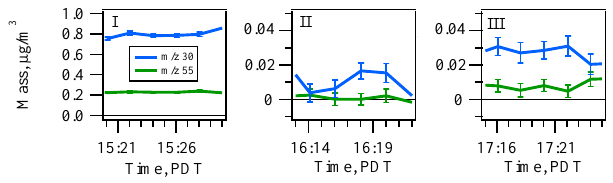
Fig. 6. Aerosol concentration and composition for experiments where 100nm ammonium nitrate (0.0015M) and 100nm adipic acid (0.00082M) were externally mixed. Panel (I) is the time series of sulfate and adipic acid mass spectra signal before the CCNC and PCVI. Panel (II) is the same quantities as in (I) but after the CCNC and PCVI at 0.5% saturation. Although the saturation was suffi- cient to activate droplets from ammonium nitrate and adipic acid, the formed droplets of adipic acid were not large enough to pass the PCVI. Panel (III) shows that the high saturation (1%) was sufficient to activate droplets from ammonium nitrate and adipic acid and the formed droplets of both particle types were large enough to pass the PCVI. Note that only ammonium nitrate, and not adipic acid signal, is evident in (IIa) and the mass spectrum in (IIb) .